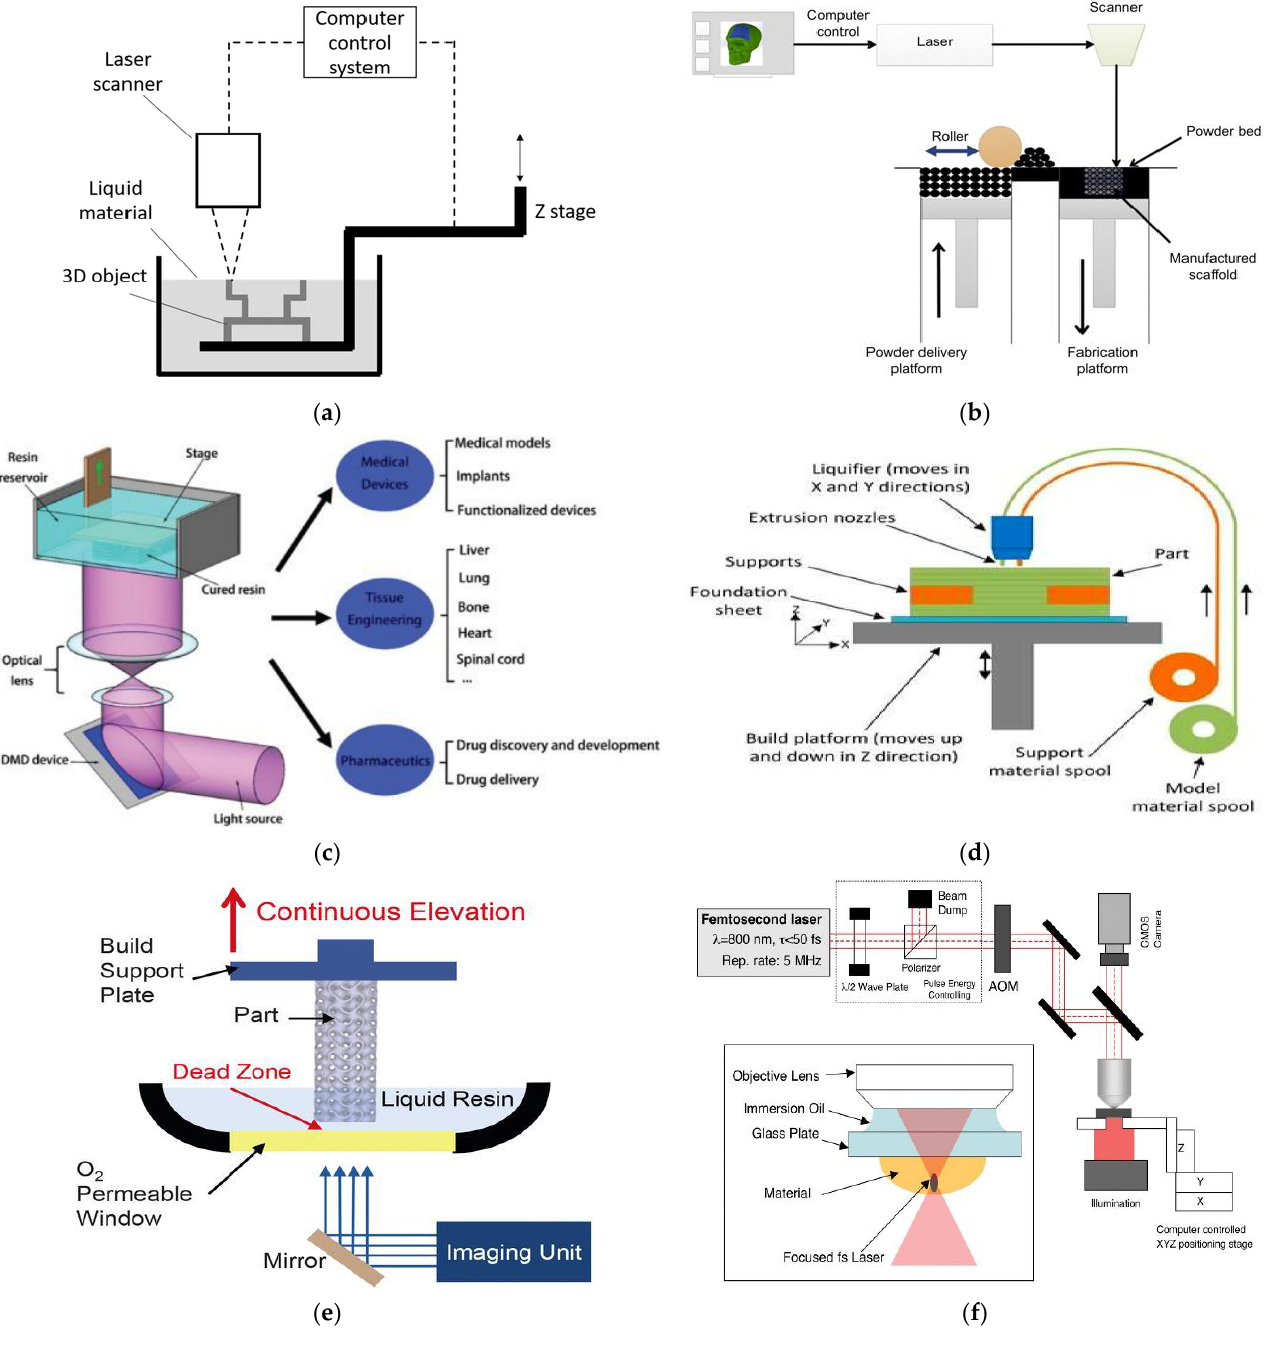
Figure 3. Schematics of the AM techniques ( a ) First-generation stereolithography [85], ( b ) Selec- tive laser sintering [103], ( c ) Digital light processing [90], ( d ) Fused Deposition Modeling [104], ( e ) Continuous liquid interface production [92], and ( f ) Two-photon polymerization process